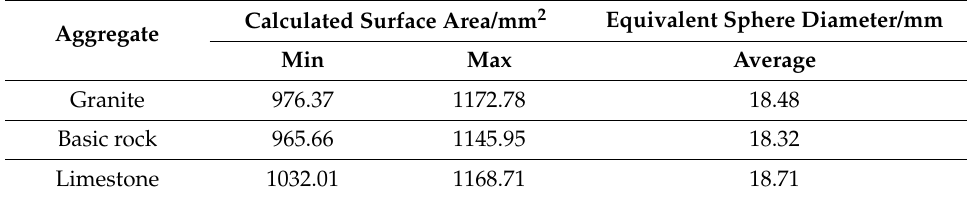
Table 3. The surface area and equivalent particle size of used rectangular aggregates.